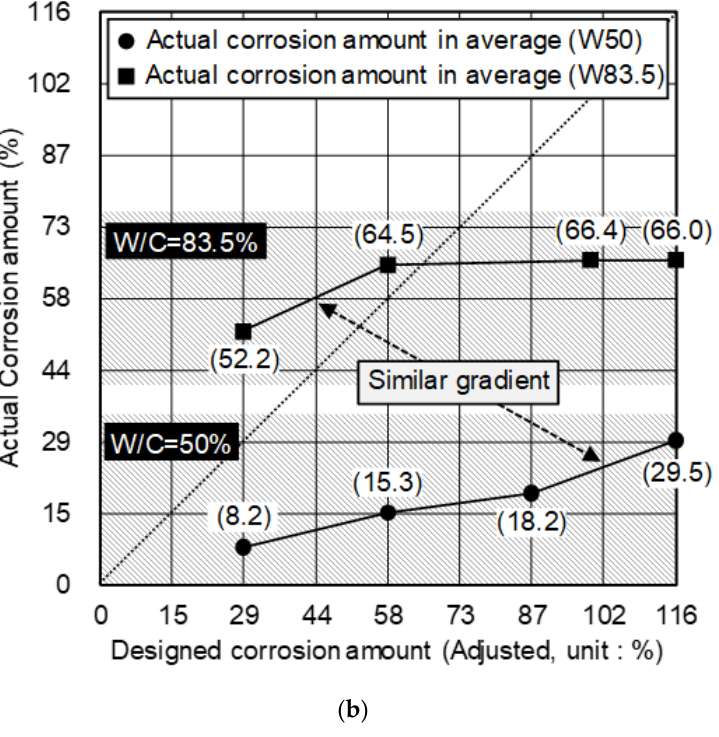
Figure 9. Comparison of the actual and designed corrosion amounts. ( a ) Result for each specimen; ( b ) Average.